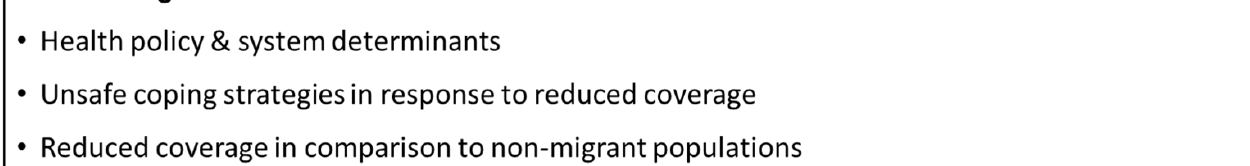
Figure 4. Themes developed from content analysis of results of individual sources of evidence, sorted against the three health coverage dimensions.